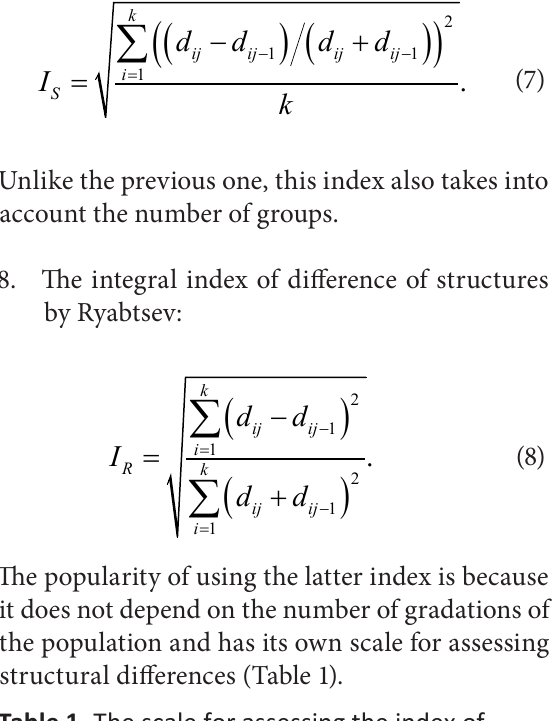
Table 1. The scale for assessing the index of differences by Ryabtsev Range of criterion values